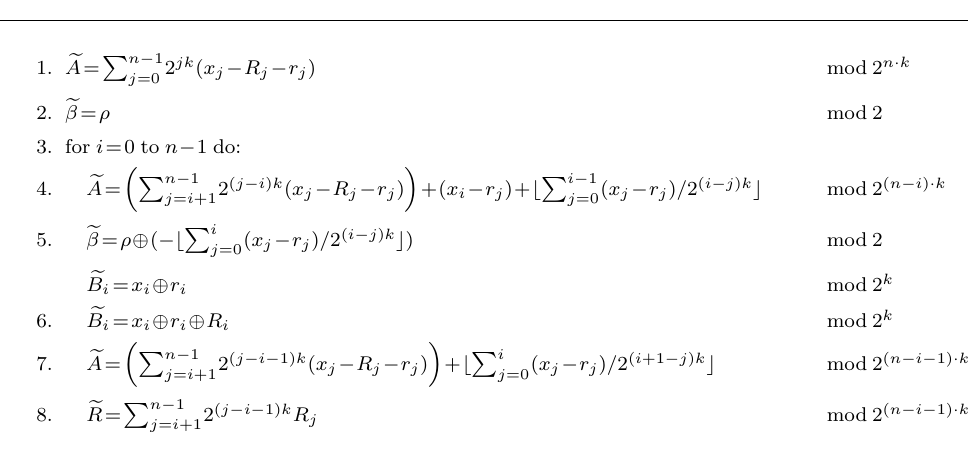
Figure 5: Intermediate values of all variables used in Algorithm 8. Variables with tilde e · are intermediate values, variables without are fixed input